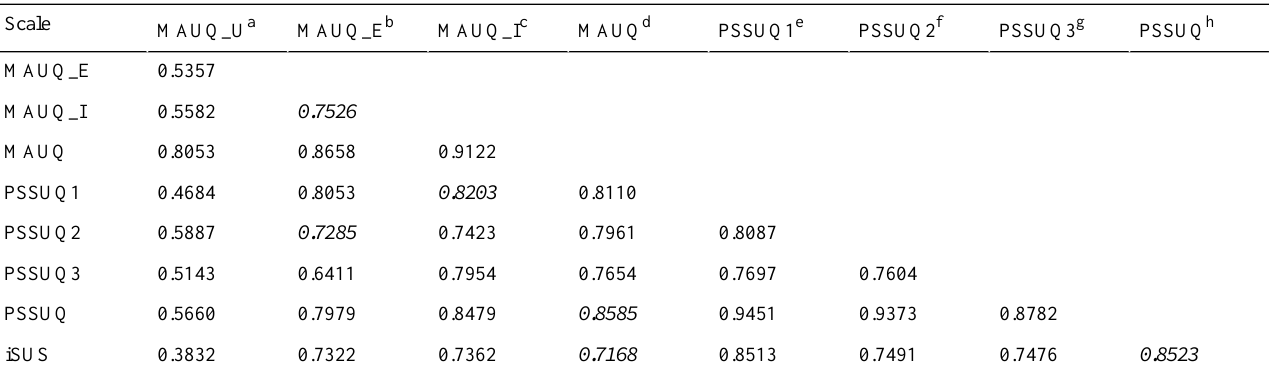
Table 5. Correlation coefficients among scores from the mHealth App Usability Questionnaire, Post-Study System Usability Questionnaire, System Usability Scale, and their subscales. Italics indicate strong correlations among the scales and their